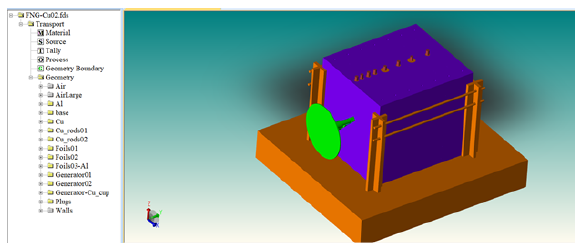
Figure 1. Experimental set-up of the FNG Copper benchmark (CAD